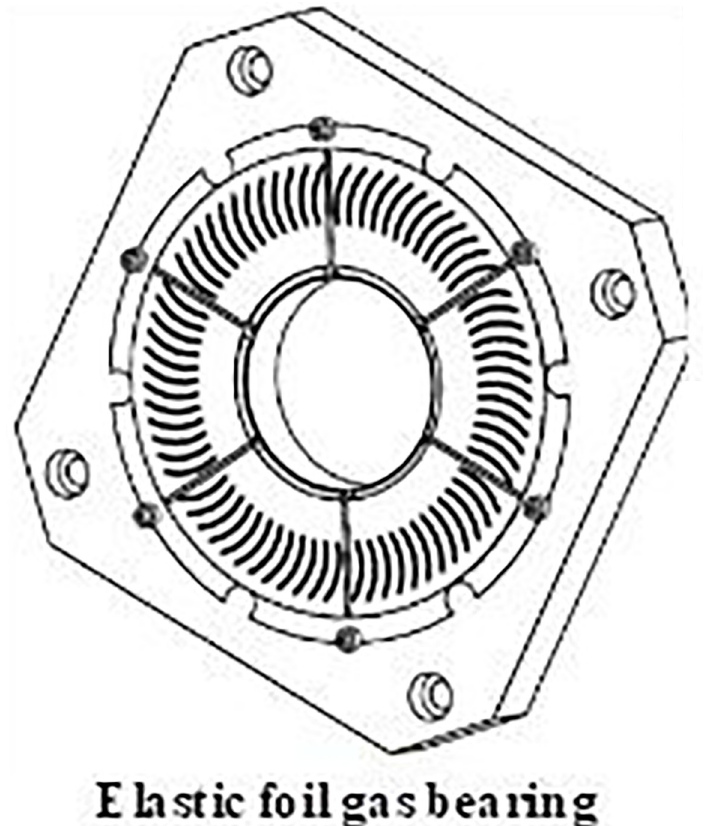
Fig 2. Basic composition of elastic foil gas